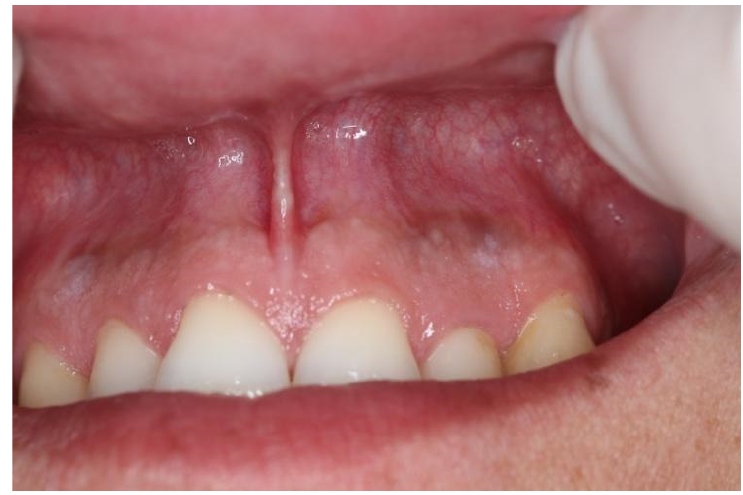
Figure 3. White, grainy lesion above tooth nr. 13/12 and tooth nr. 22/23.